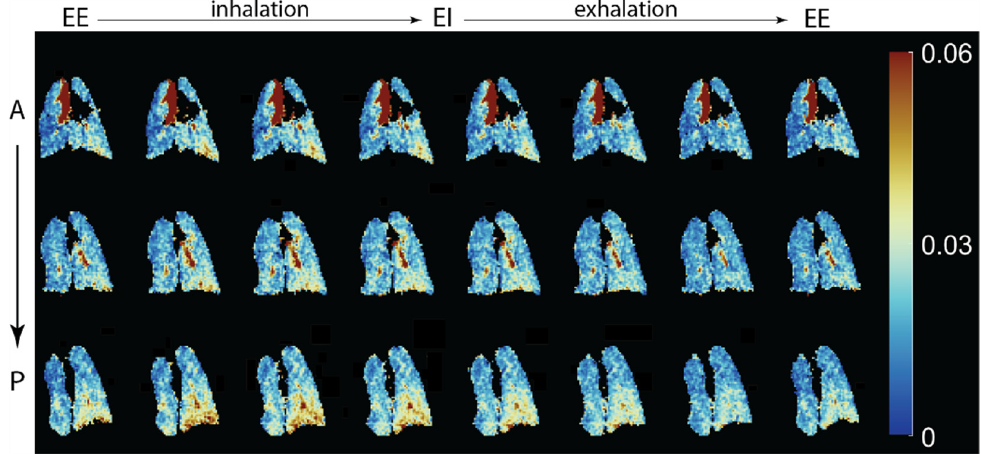
Figure 9. A dynamic map of HXe ADC in a free-breathing porcine model of restriction in thoracic insufficiency syndrome [39] depicts the essential features of this measurement. Free diffusion in the trachea and large airways is reduced by a factor of ~2.5 in the lung parenchyma due to collisions with the alveolar and small airway structure. ADC is modestly increased during inhalation proximal to the diaphragm, but only in the unrestricted lung which is significantly expanded during breathing. The color map depicts local ADC values in the range 0–0.06 cm 2 /s; as noted below nu- merical values depend on the exact choice of gas mixture, and diffusion-encoding gradient strength and timing, but these qualitative trends are universally observed [40].